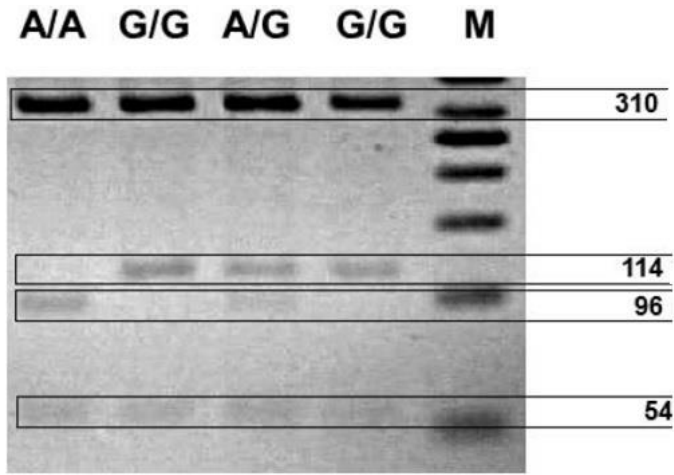
Figure 1. Photo of the digested COMT PCR products. The results are labeled by genotype: Met/Met (A/A), 96 bp only; Val/Met (A/G) 114 and 96 bp; and Val/Val (G/G), 114 bp only.